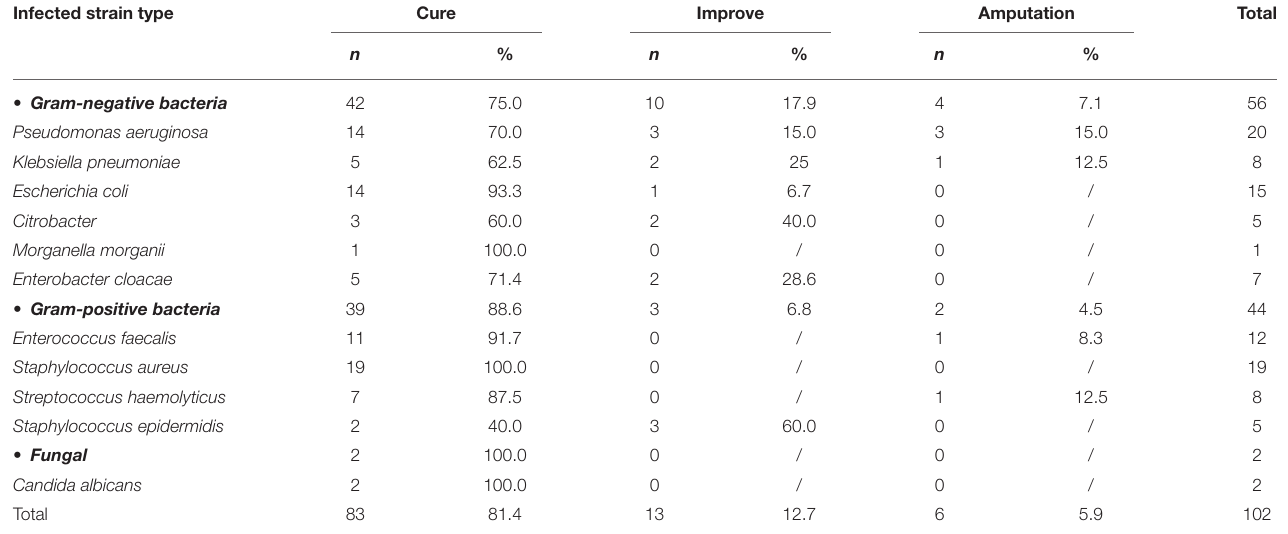
TABLE 6 | Therapeutic outcomes of the 102 DFI